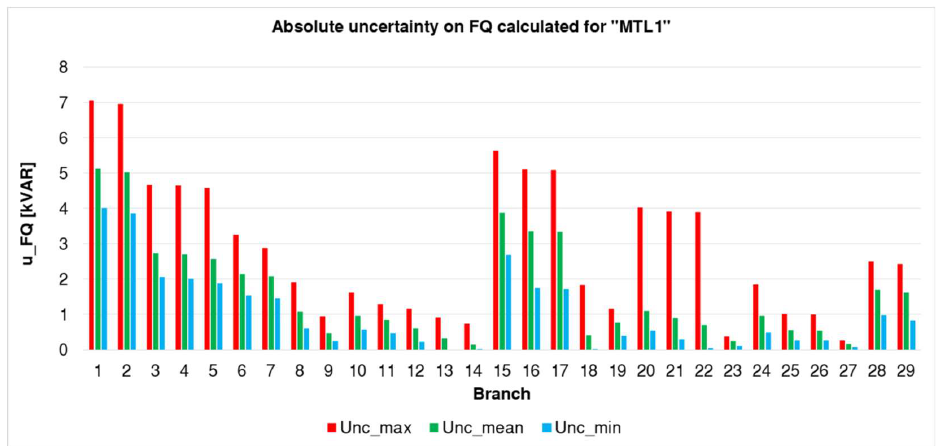
Figure 16. Maximum, average and minimum values of the absolute uncertainties in the reactive power flows calculated of the “MTL1” line (31 May 2018).